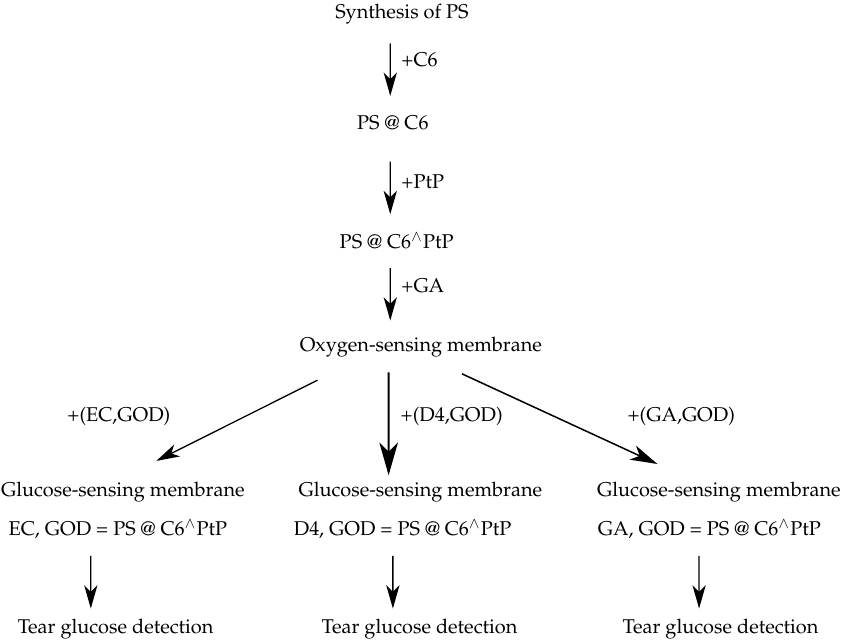
Figure 3. Fabrication of radiometric fluorescent glucose-sensing membranes (Adapted from Ref. [58]). Table 1. Response characteristics of each supporting material according to the results of